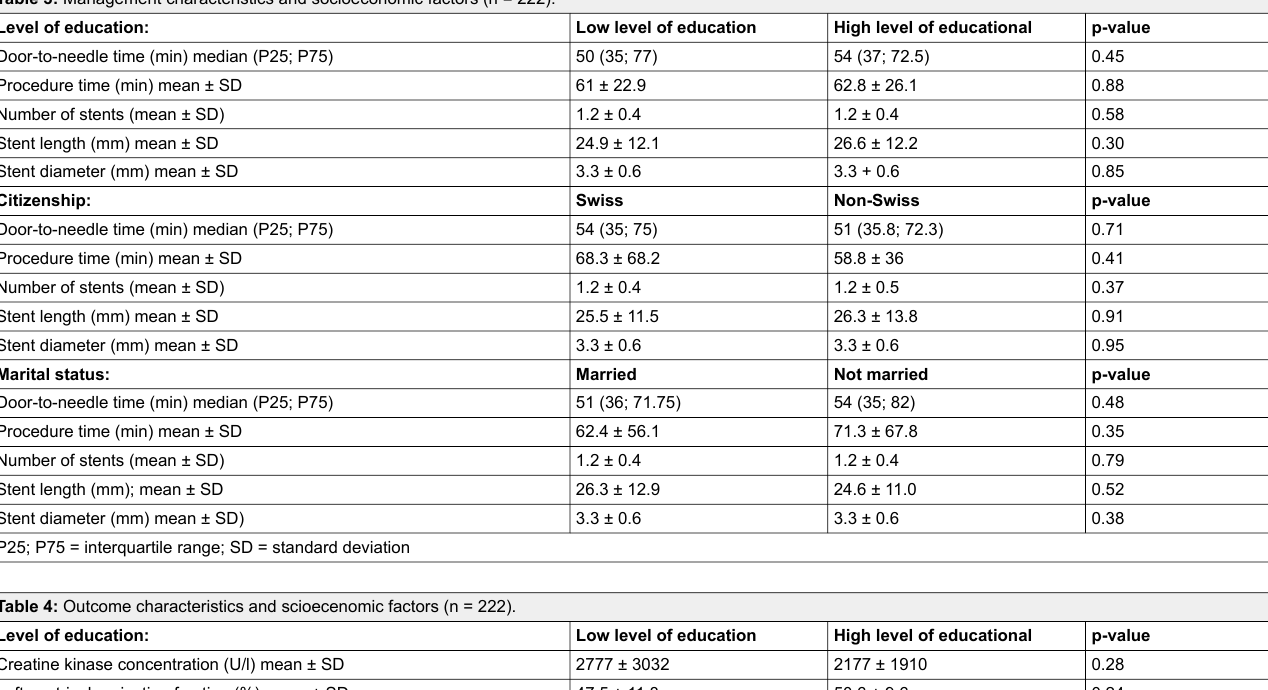
Table 3: Management characteristics and socioeconomic factors (n = 222). Level of education: